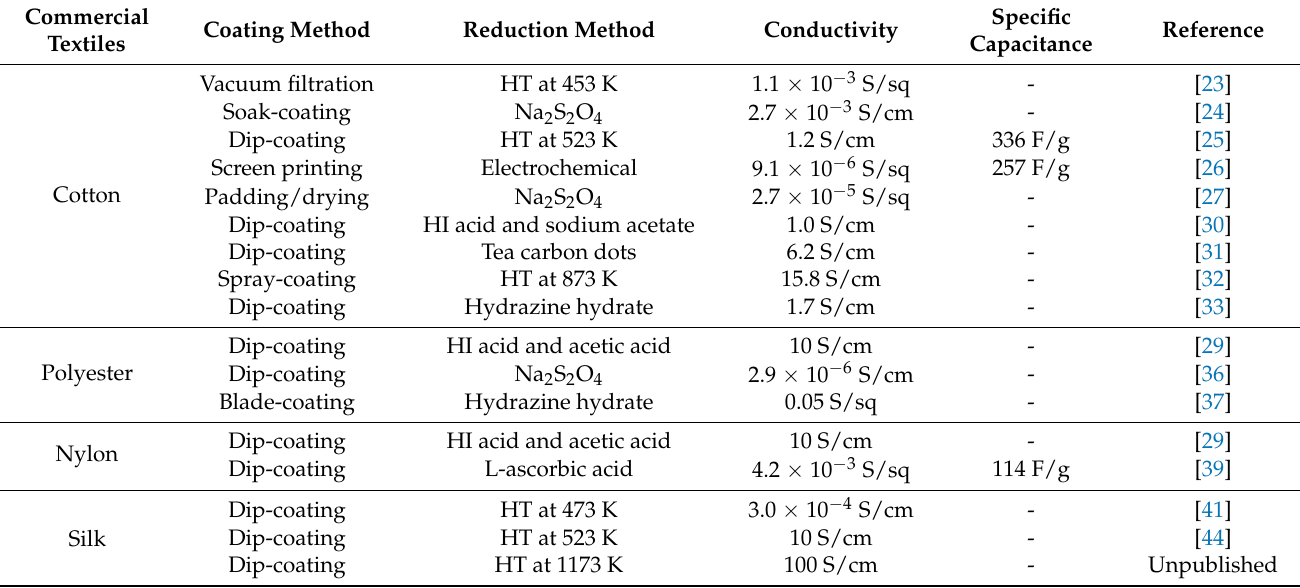
Table 1. Characteristics of rGO-coated e-textiles. The different conductivity came from the reduction methods, reduction temperature, and heating rate ( ◦